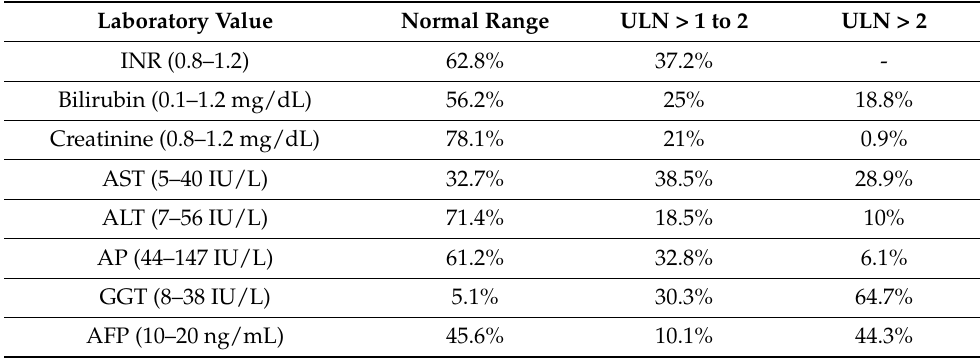
Table 2. Laboratory values before the first DSM-TACE